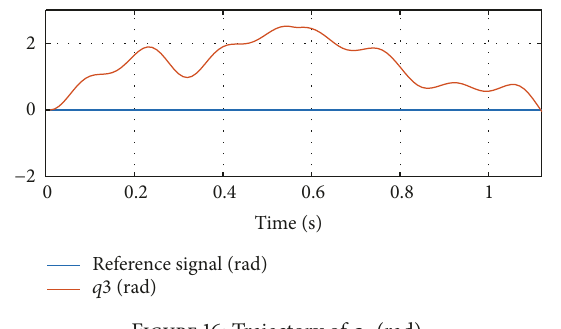
Figure 16: Trajectory of 𝑞 3 (rad).